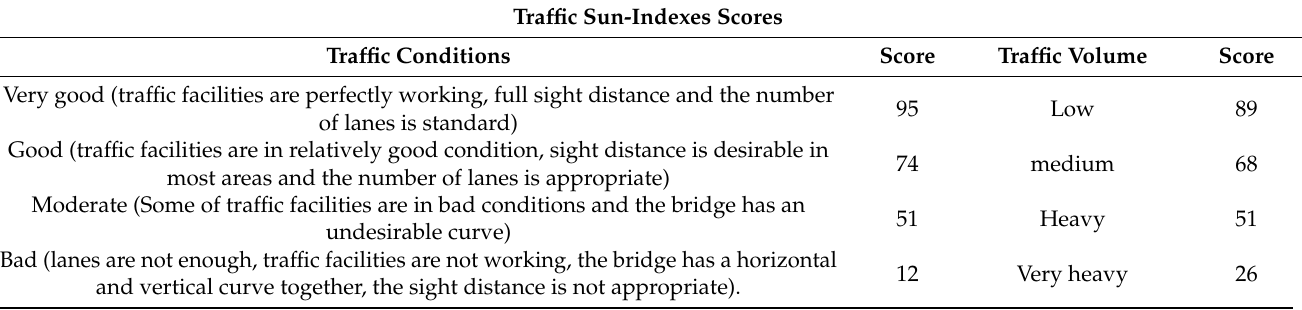
Table 17. Scores of traffic